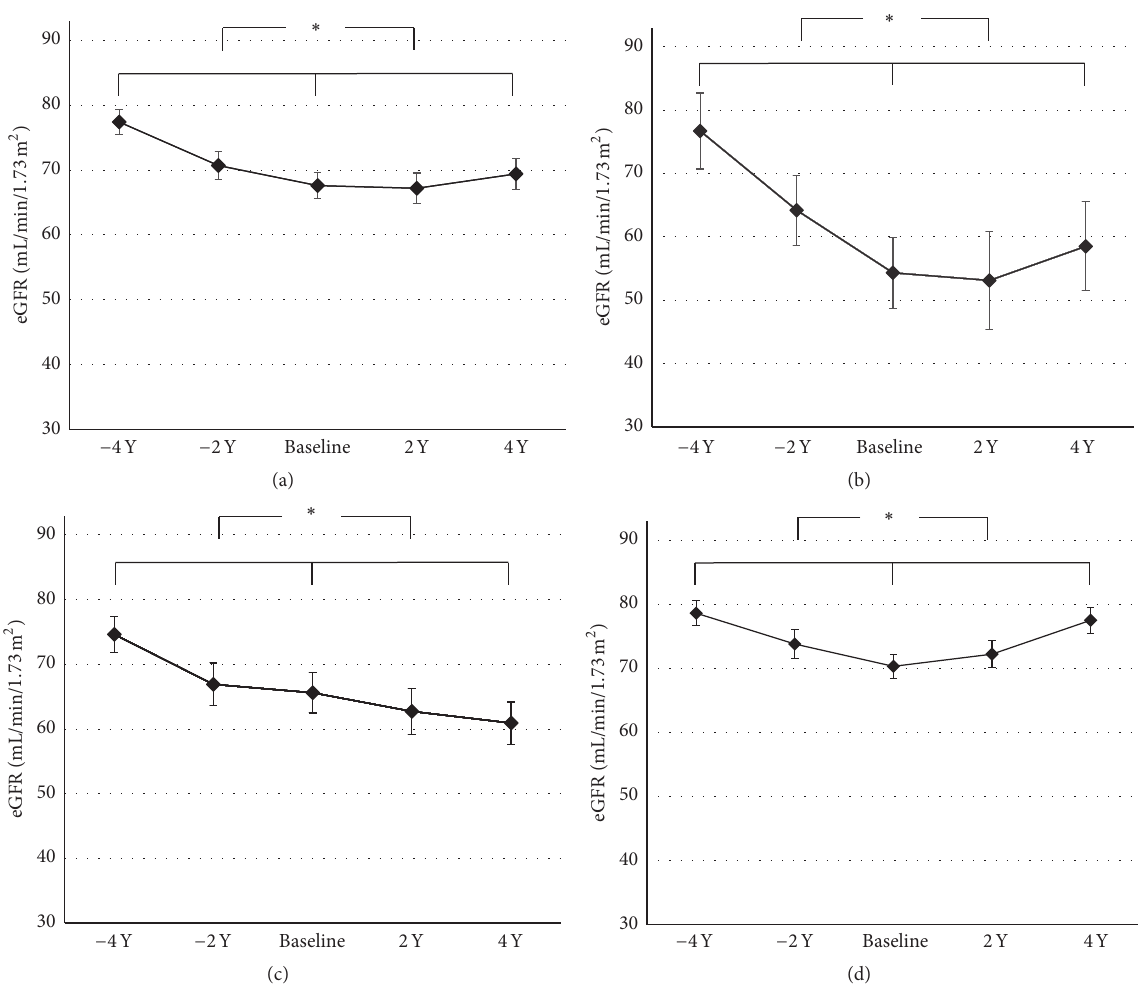
Figure 2: Changes in eGFR 4 years before and 4 years after DPP-4i treatment initiation. Changes in eGFR in all patients (a) and in patients with macroalbuminuria (b), microalbuminuria (c), and normoalbuminuria (d). Baseline values are the means with standard errors. DPP-4i: dipeptidyl-peptidase IVinhibitor; UACR: urine albumin/creatinine ratio; − 4 Y: 4 years before DPP-4i treatment initiation; − 2 Y: 2 years